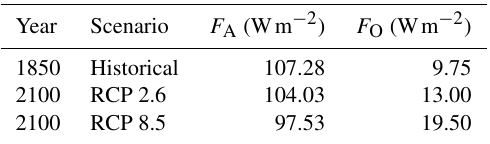
Table 2. Atmosphere and ocean heat fluxes into the Arctic as sim- ulated in Koenigk and Brodeau (2014), using the global coupled climate model EC-Earth.